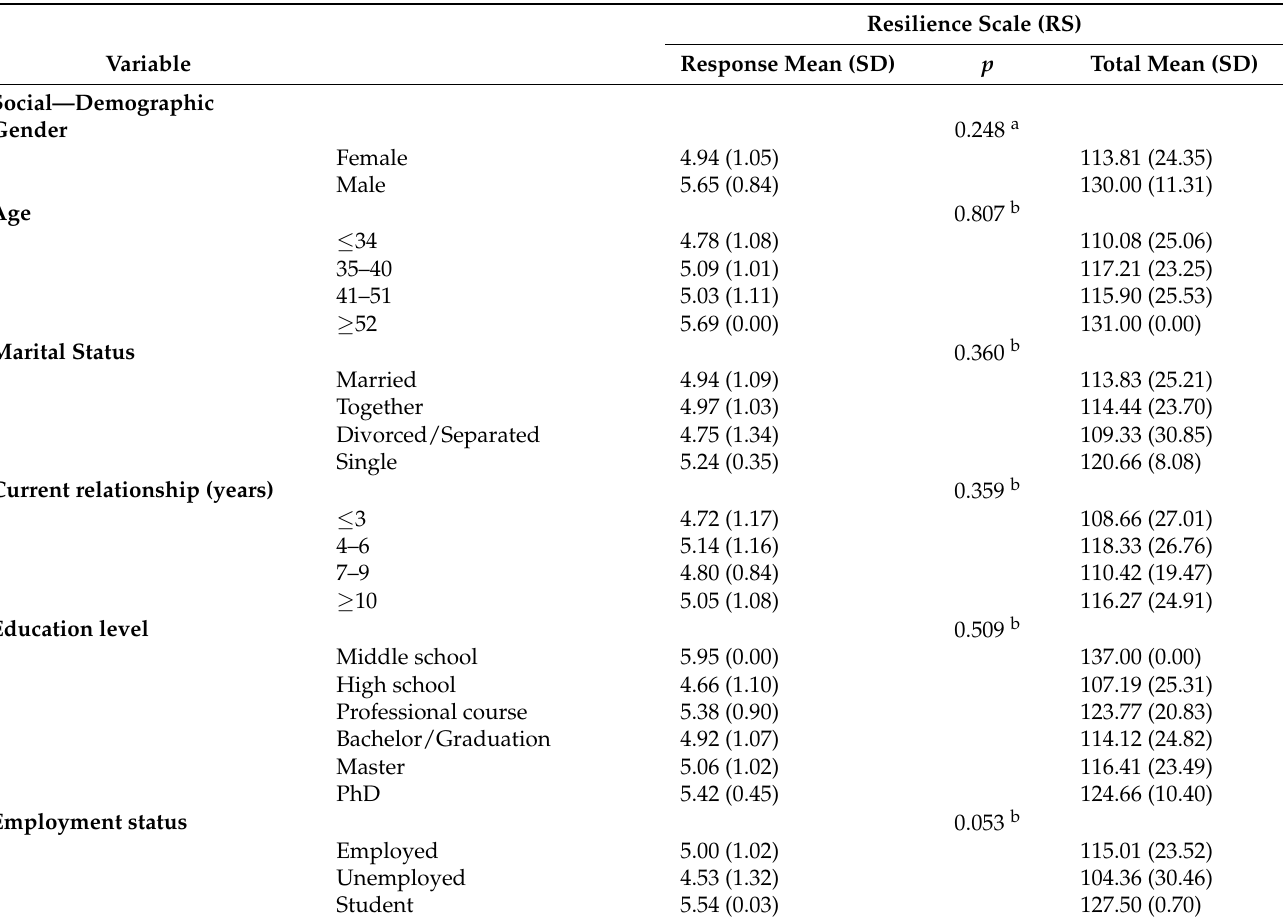
Table 1. Mean scores of the RS by characteristics of participants ( n =